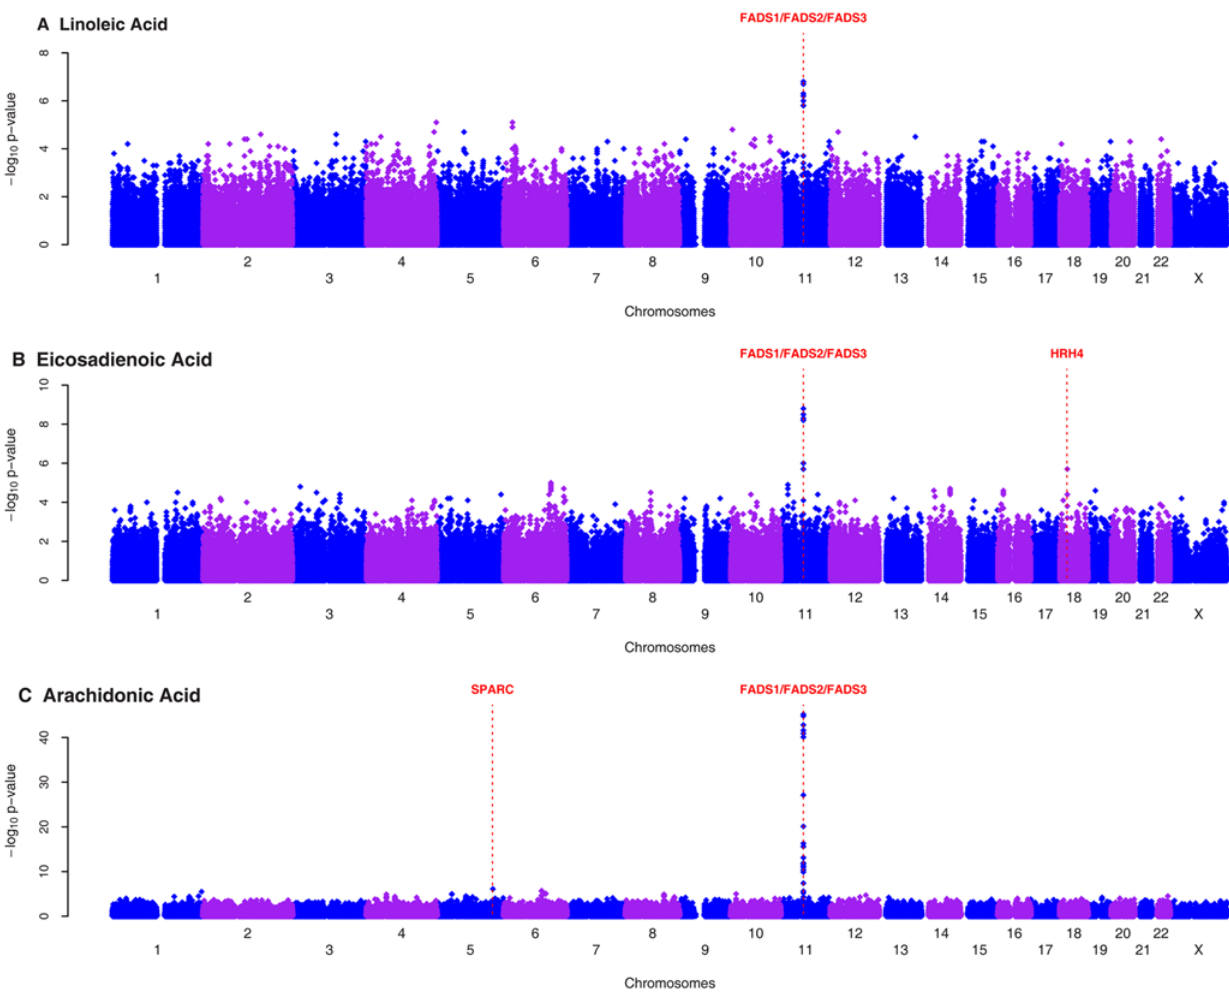
Figure 2. Genome-wide scans of omega-6 fatty acid profiles in InCHIANTI study. Genome-wide associations of plasma linoleic acid (A), eicasadienoic acids (B) and arachidonic acid (C) with 495,343 autosomal and X chromosome SNPs that passed quality control graphed by chromosome position and 2 log10 p-value. The most significant variant was within the FAD1/FAD2/FAD3 cluster on chromosome 11. The genes nearby or within the SNPs that were selected for replication in GOLDN are indicated.